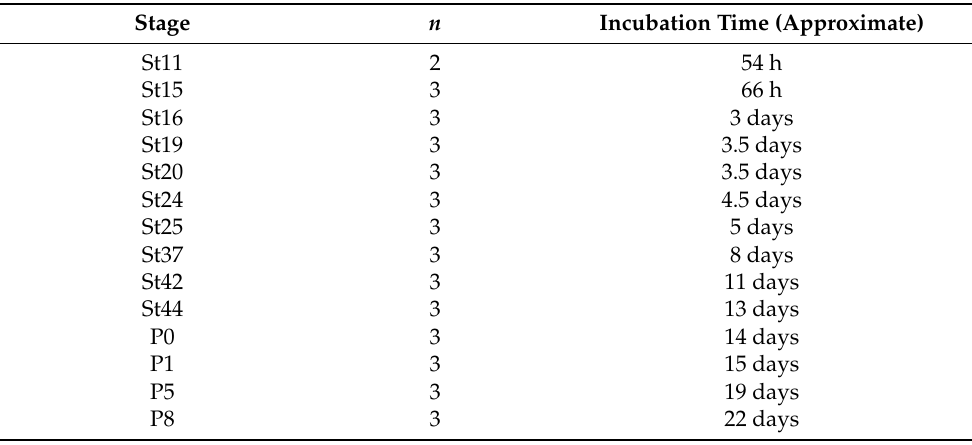
Table 1. T. guttata embryos and hatchlings used in the present